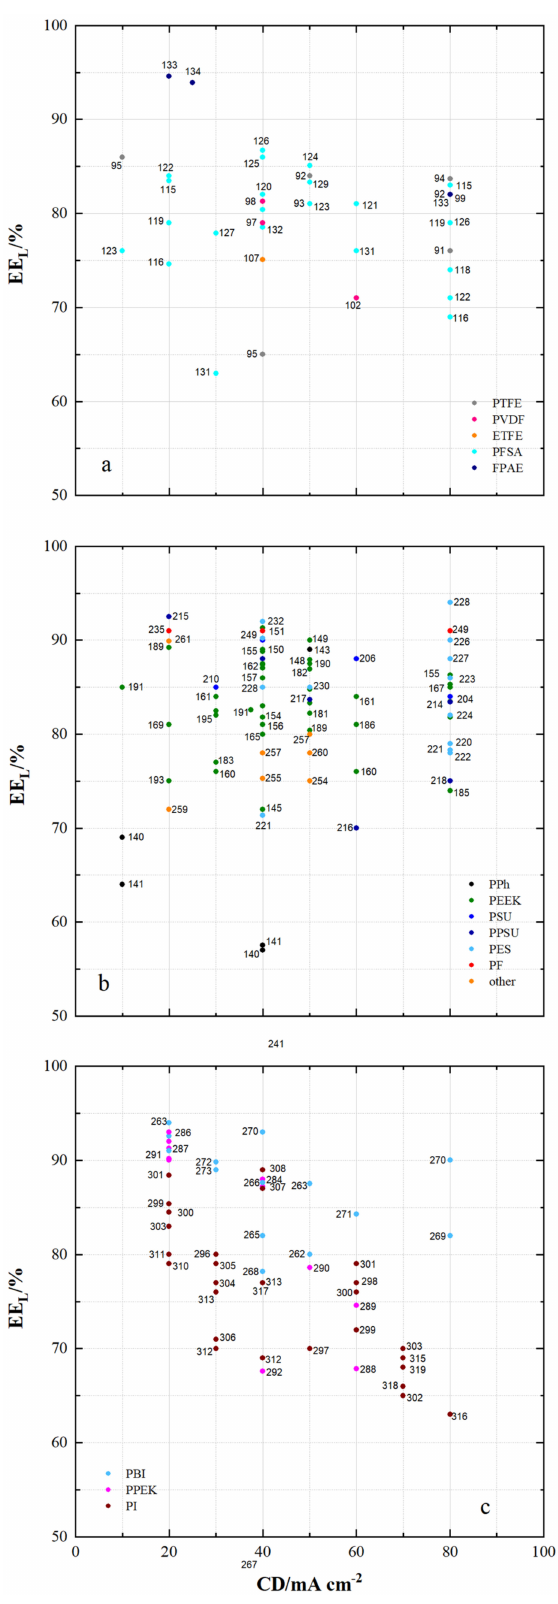
Figure 11. The energy efficiency of VRFB cells by using membrane samples at current densities < 100 mA cm − 2 : ( a ) fluoro-carbons, ( b ) hydro-carbons and ( c ) N